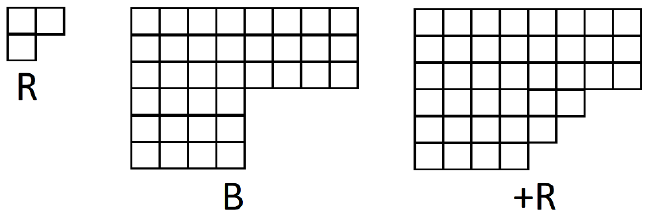
Figure 4 . An example showing Young diagrams R , B and + R . The Young diagram + R is obtained by stacking R next to B